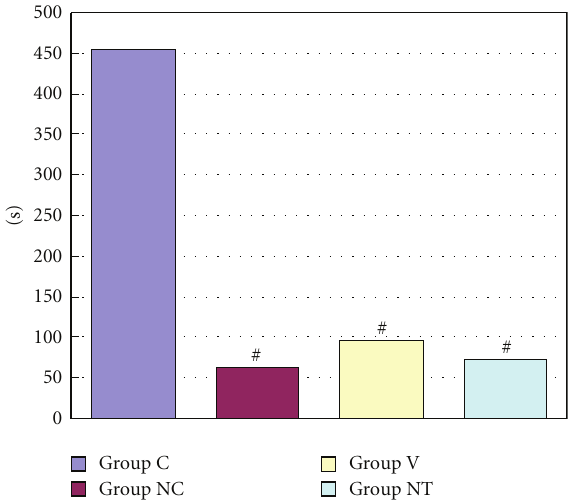
Figure 6: The figure shows duration of arrhythmias during myocardial ischemia. Group C: a control group. Group NC: a nicardipine group. Group V: a verapamil group. Group NT: a nitroglycerin group. # Significantly di ff erent ( P < . 05) from Group C (mean ± S.D.).